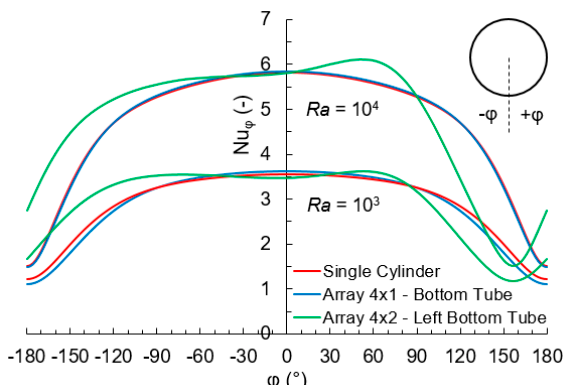
( f ) Figure 8. The temperature fields of the cylinder and tube arrays 4 × 1, 4 × 2: ( a ) single cylinder at Ra = 10 3 ; ( b ) single cylinder at Ra = 10 4 ; ( c ) tube array 4 × 1 at Ra = 10 3 ; ( d ) tube array 4 × 1 at Ra = 10 4 ; ( e )